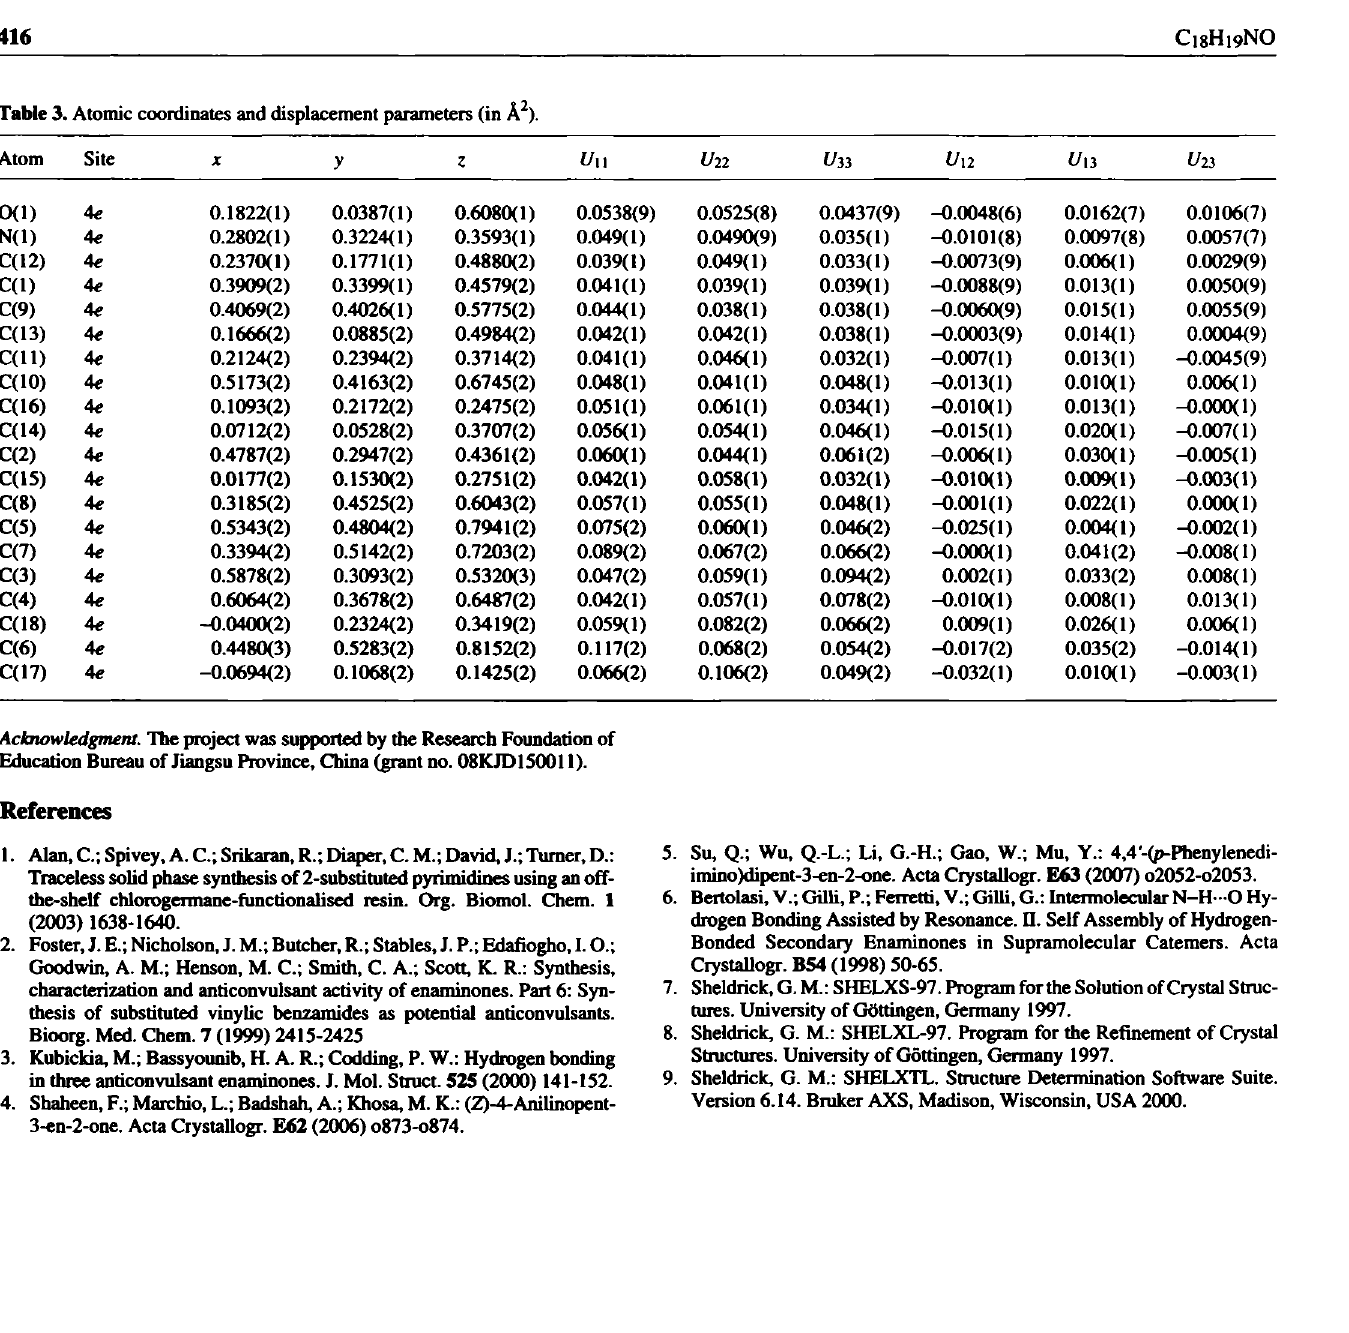
Table 3. Atomic coordinates and displacement parameters (in Â 2